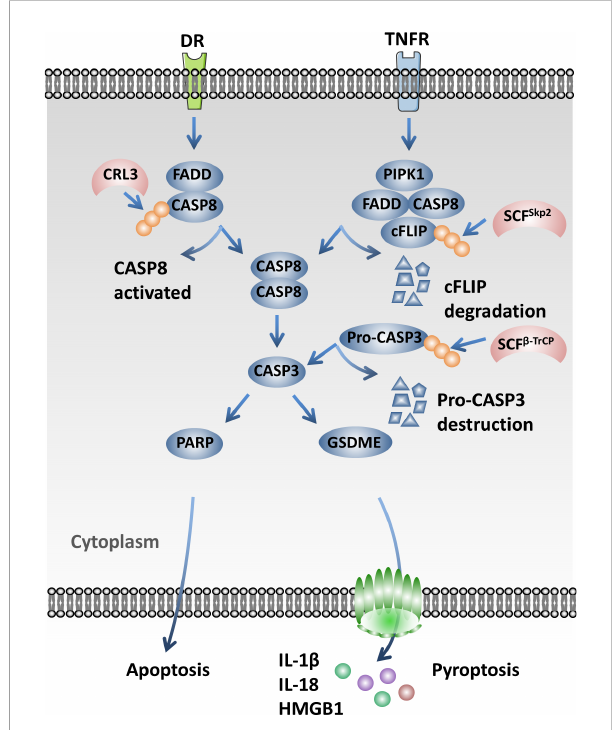
FIGURE 4 Cullin-RING ligases (CRLs) in fl uence pyroptosis through regulating the caspase signaling pathway. Cul3-based ubiquitin ligases mediate the poly-ubiquitination and activation of caspase 8, which is essential for the assembly of the death-inducing signaling complex (DISC) under the treatment of extrinsic apoptosis signaling. SCF Skp2 promotes the ubiquitination and degradation of FLIP(L). SCF b -TrCP mediates the degradation of pro-caspase 3 by the 26S proteasome and protects cells from